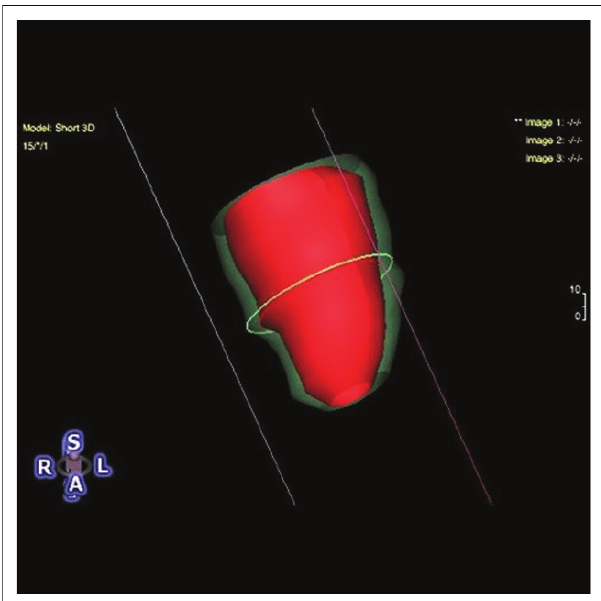
Source : Scholtz and Partners Radiologists. FIGURE 2: Three-dimensional image indicating the level of the short-axis image obtained.